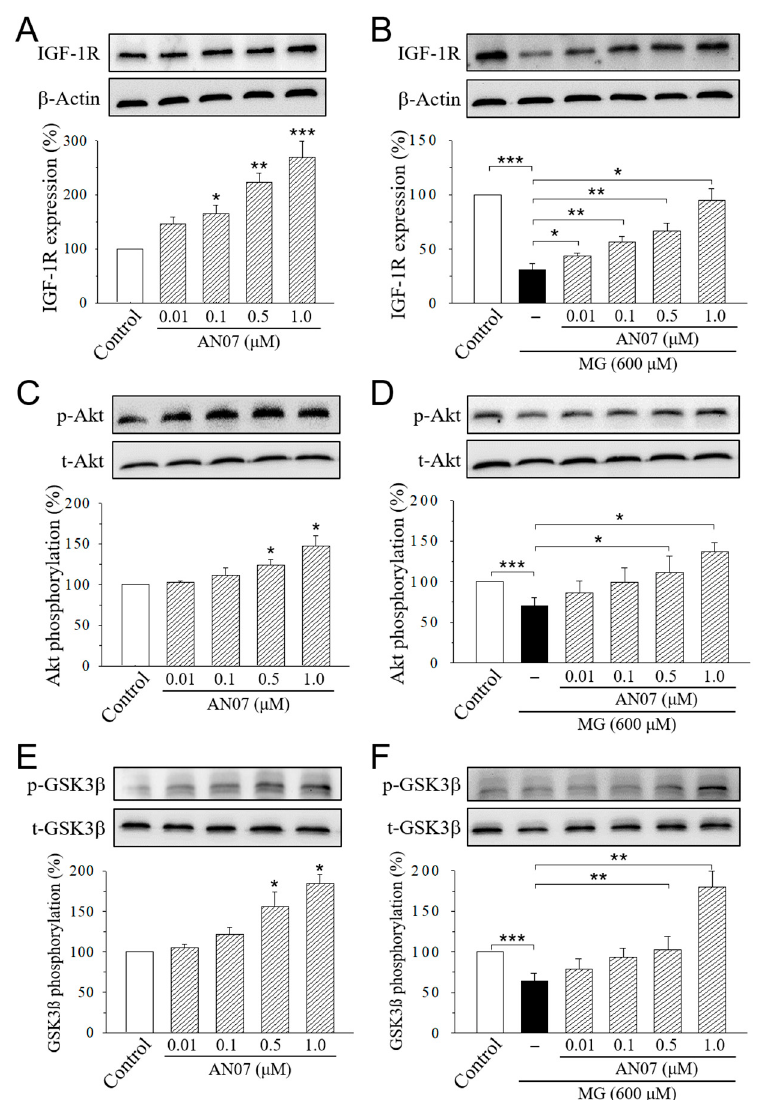
Akt (Figure 7C) and glycogen synthase kinase-3 β (GSK3 β ) (Figure 7E) were found in the cells treated with AN07 at 0.01–1.0 µ M. Treatment with MG (600 µ M) significantly decreased the expression of IGF-1R, p -Akt, and p -GSK3 β , which was attenuated by the pre-treatment with AN07 at 0.01–1.0 µ M in a concentration-dependent manner (Figure 7B,D,F).